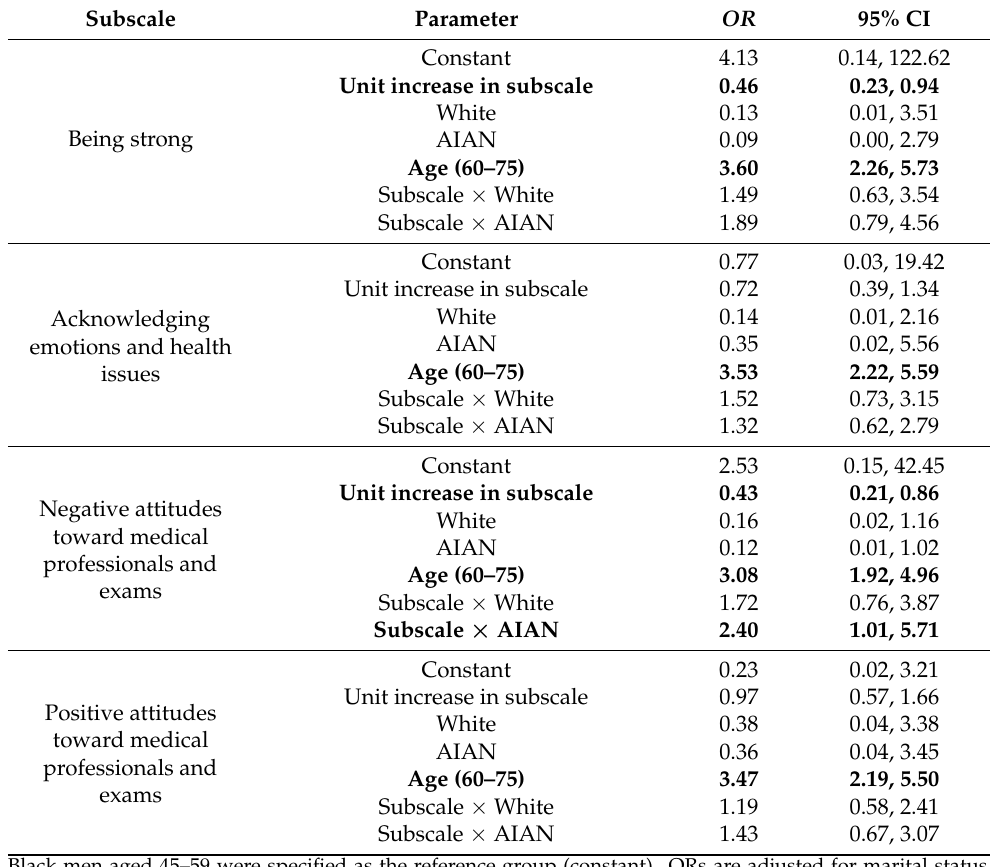
Table 3. Odds ratios (ORs) for the odds of ever having completed colorectal cancer screening among Black, AIAN, and White men (fully adjusted model).